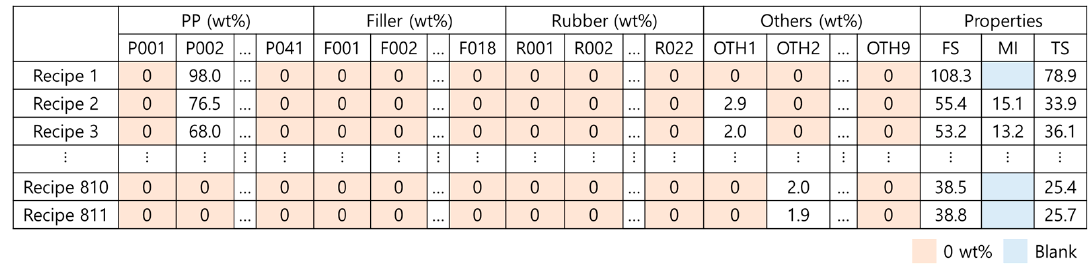
Figure 2. Raw data of PP composite recipes, including 90 types of material and FS, MI, and TS. Table 1. The number of different materials used per PP composite component.